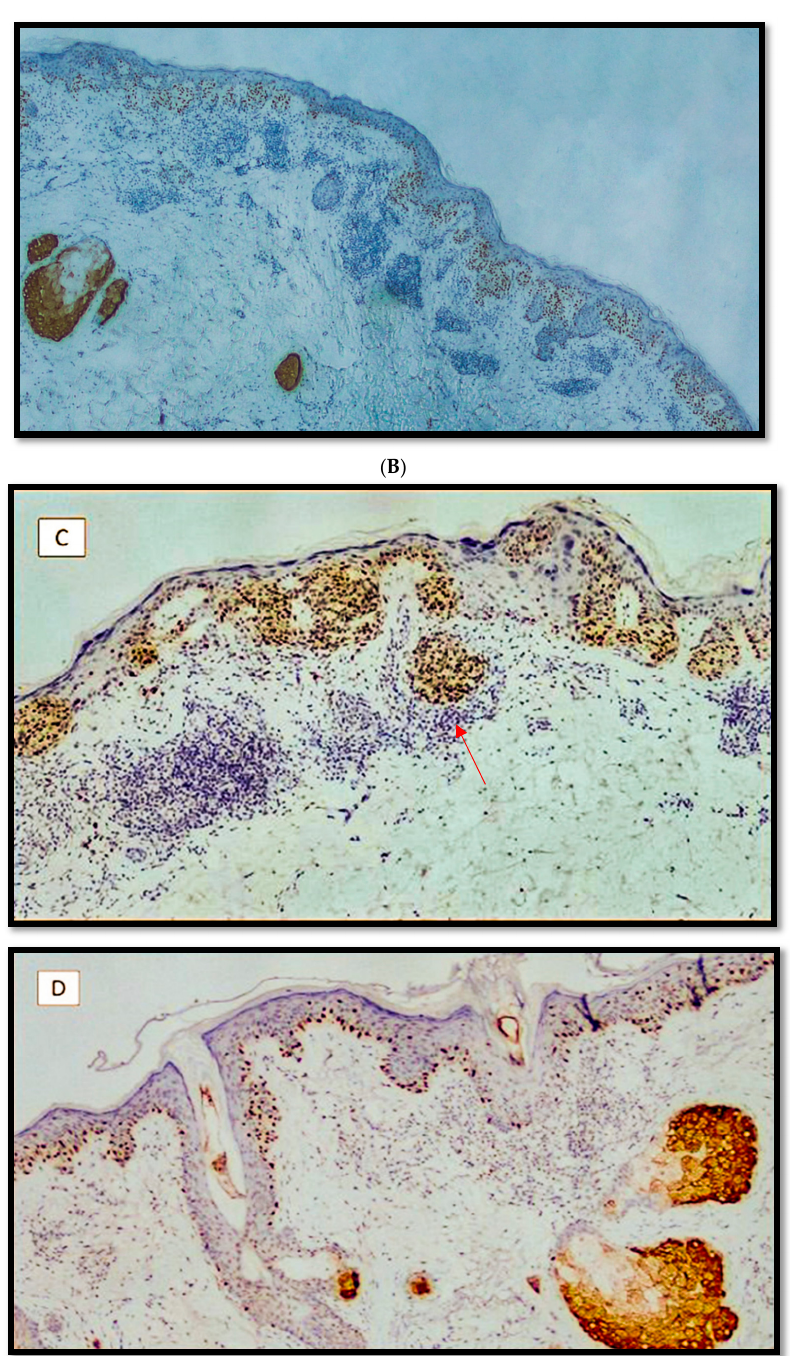
Figure 1. ( A ) Immunostaining for PRAME in a nevus with high-grade dysplasia sec. WHO 2018. Note some nuclear positivity in junctional melanocytes. Bottom right there is a sebaceous gland used as control (immunostaining for PRAME, original magnification 10 × ); ( B ) immunostaining for PRAME in a lesion classified as MELTUMP: note the heterogeneous nuclear staining of nests of melanocytes with areas of positivity and negativity (immunostaining for PRAME, original magnification 10 × ); ( C ) example of strong nuclear immunopositivity for PRAME in an SSM. Note the nests of neoplastic melanocytes with elongated rete ridges and a focal aspect of invasivity (red arrow); ( D ) an example of LMM immunostained with anti-PRAME antibody: note the strong nuclear positivity of neoplastic cells above the dermo-epidermal junction, with occasional pagetoid spreading and some focus of melanocytic conglomeration (immunostaining for PRAME, original magnification 10 ×